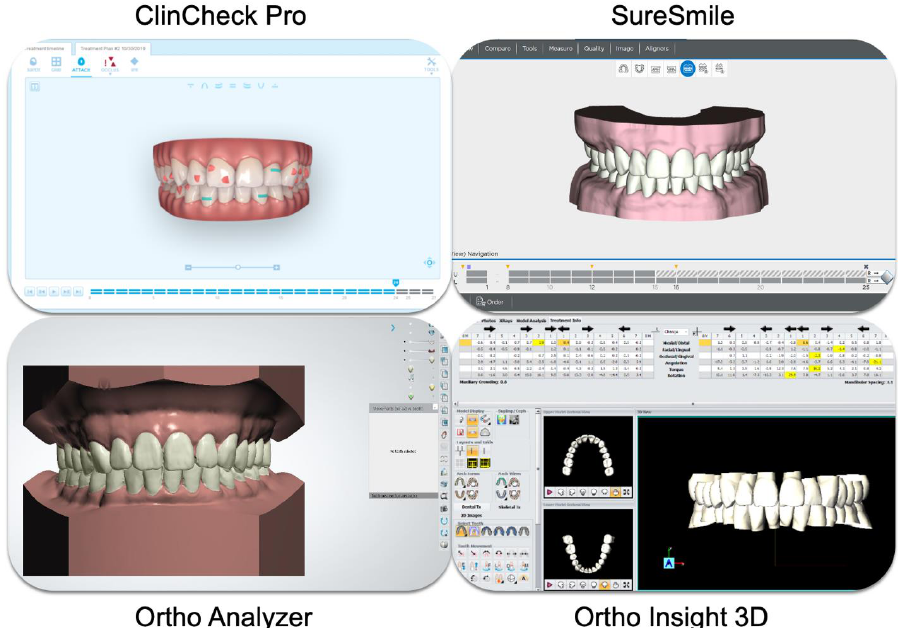
Figure 1. Replicated virtual setups from ClinCheck ® Pro, Ortho Analyzer ® , SureSmile ® , and Ortho Insight 3D ® .